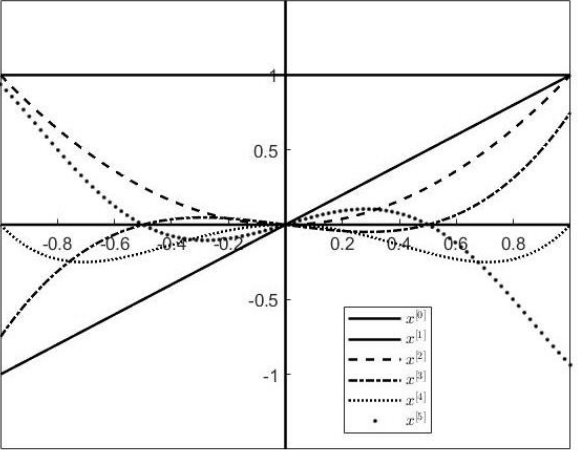
Figure 1. Central factorial